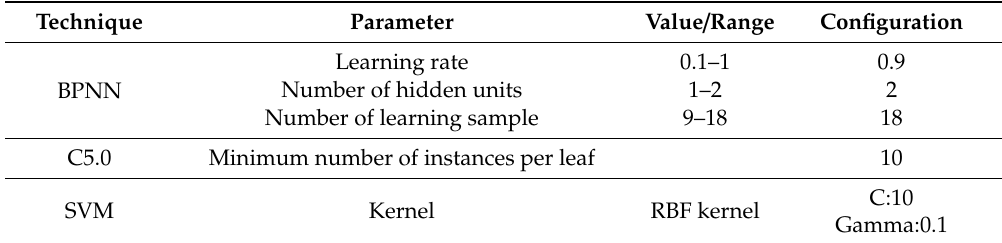
Table 2. Parameter settings in each